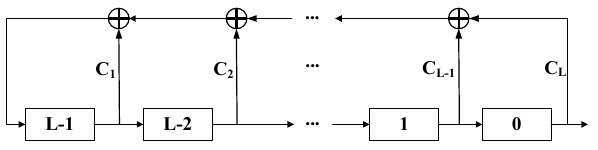
Figure 2. External XOR LFSR.